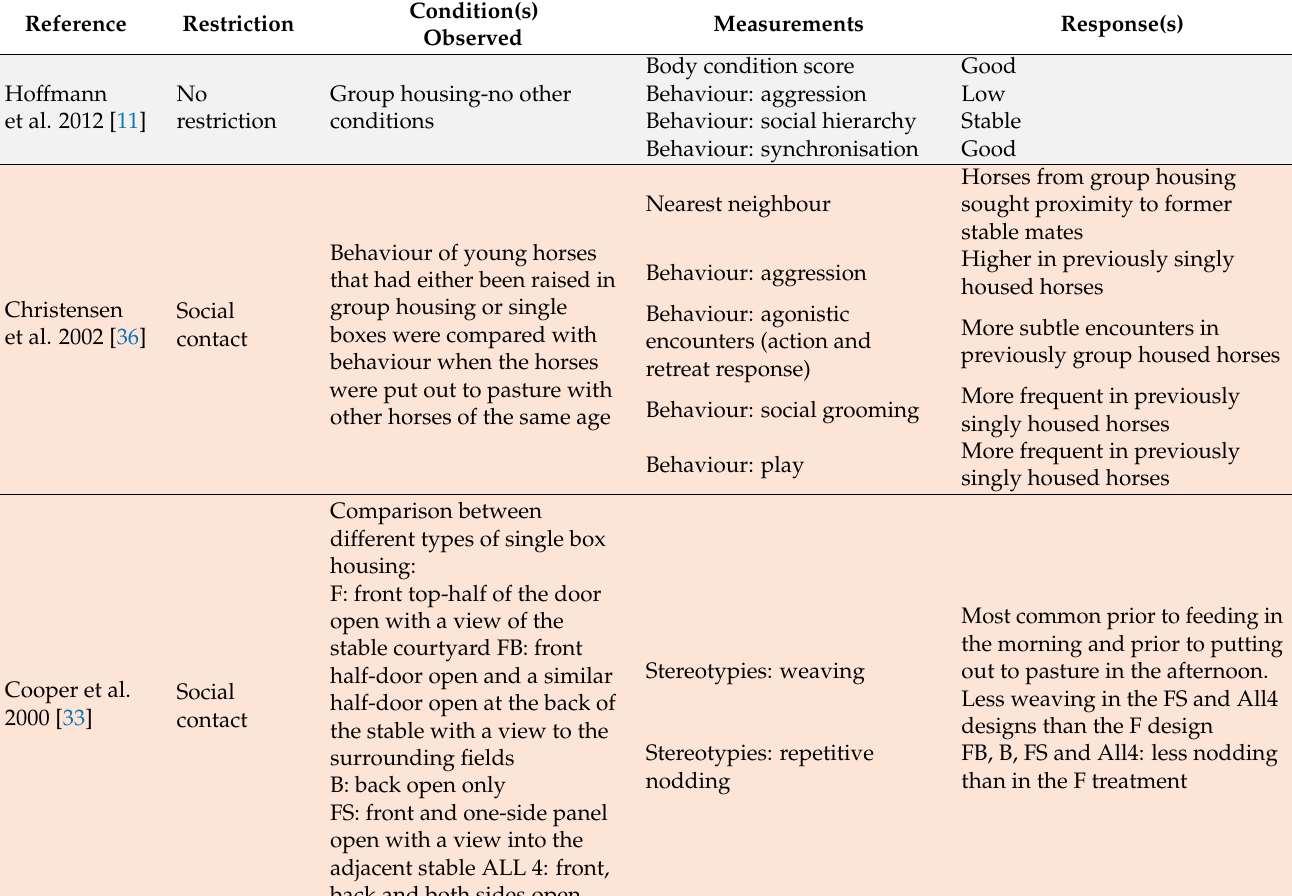
Table 1. Literature on restrictions in “proposed basic needs” in horses. Background colours indicate studies on the restricted basic needs: grey = no restriction, light orange = social contact, light blue = social companionship, light yellow = movement, dark grey = feed, orange = social contact and feed, green = movement and social contact, yellow = movement, social contact and feed. The columns list the test condition or changes in test conditions, the response measurements and the horses’ responses that were observed. For detailed information on the horses and their management conditions please see Supplementary Materials (Table